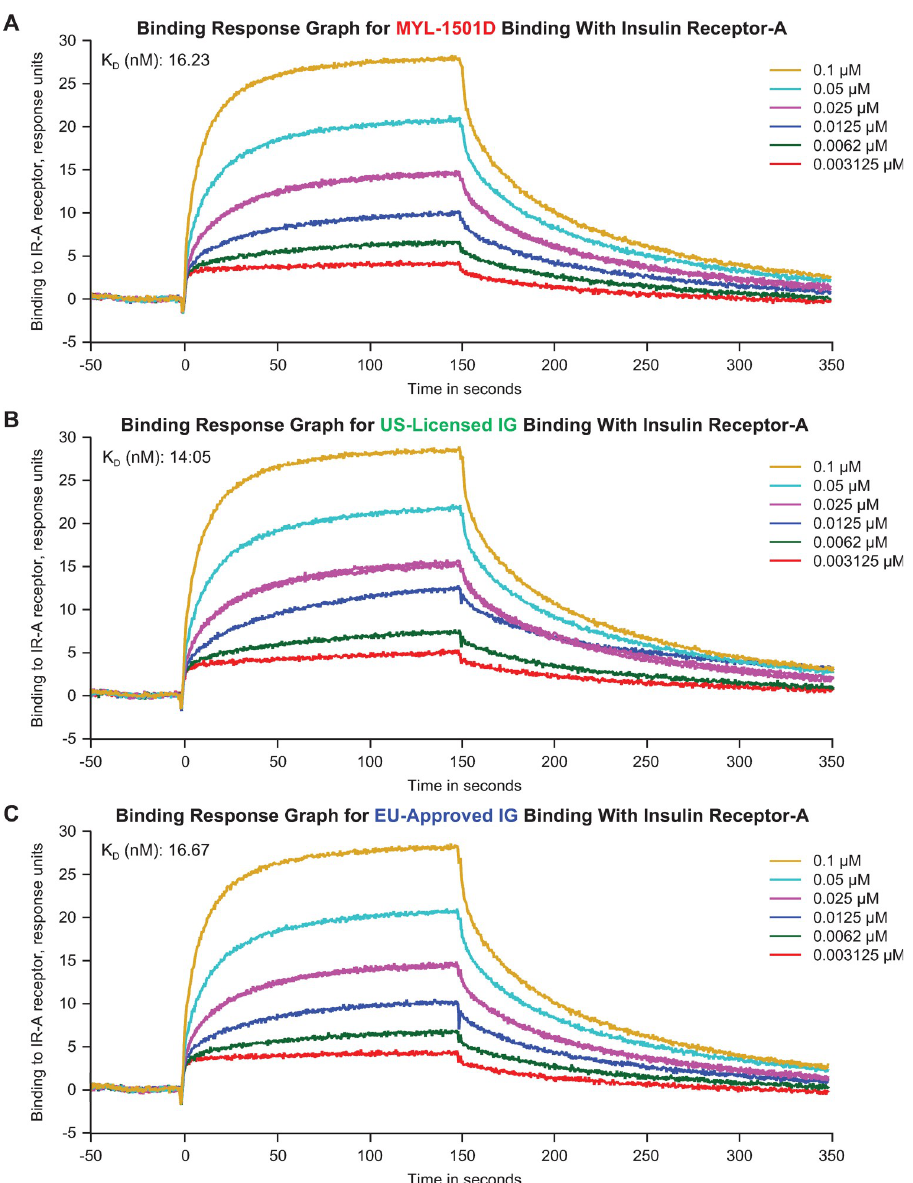
Fig 6. Representative binding response graphs of the insulin receptor-A (short-form) kinetic binding assay. (A) MYL-1501D, (B) US-Licensed Insulin Glargine, and (C) EU-Licensed Insulin Glargine. Each lot was analyzed over 6 concentrations, and kinetic parameters were evaluated by 1:1 interaction model using global fit. Each lot was analyzed 3 independent times, and mean K D value was reported. K D , equilibrium dissociation constant.